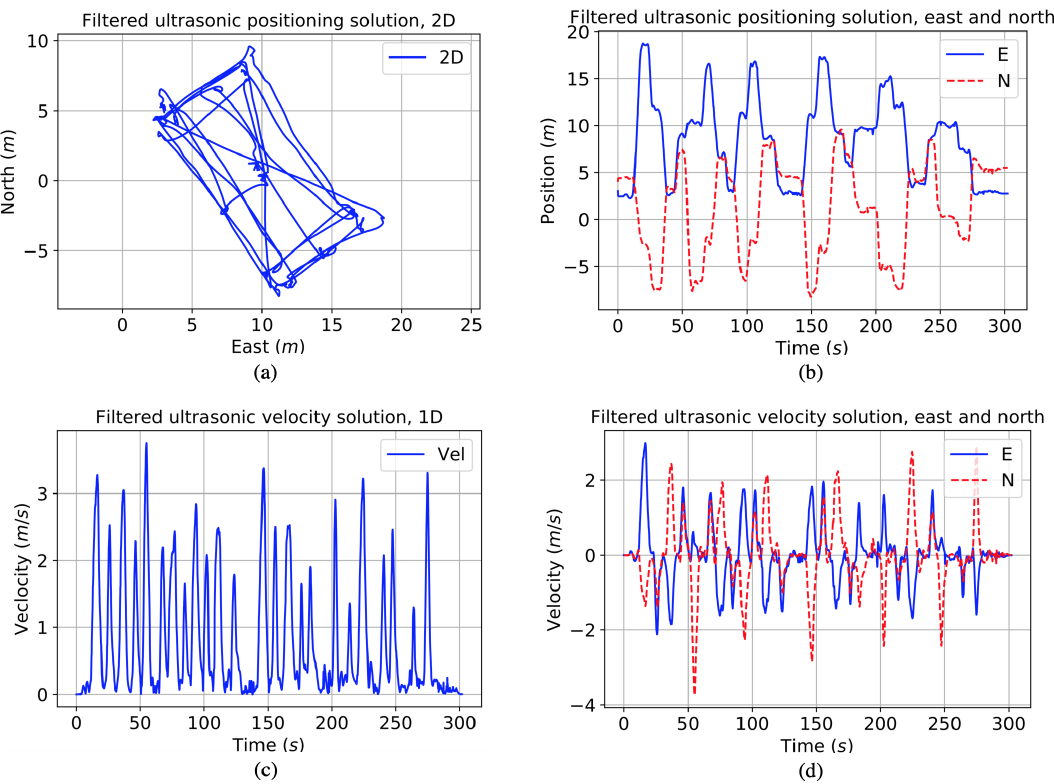
Figure 10. ( a ) AHRS/INS/Velocity/Ultrasound integrated 2D location, ( b ) east and north positions, ( c ) 1D velocity, and ( d ) east and north